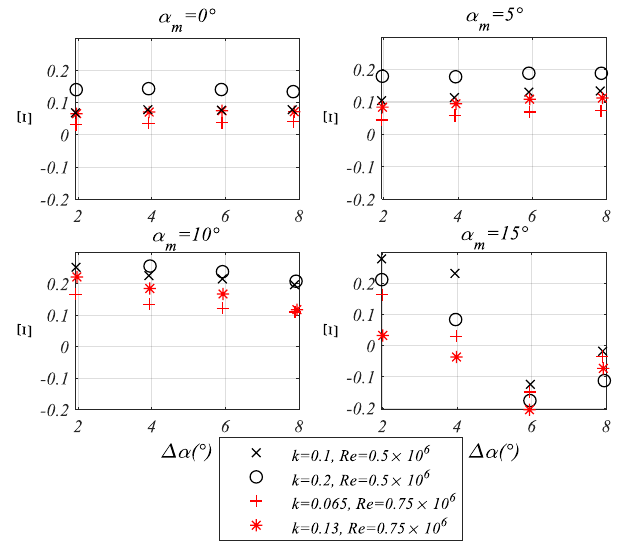
Figure 22. Aerodynamic damping coefficient versus amplitude.